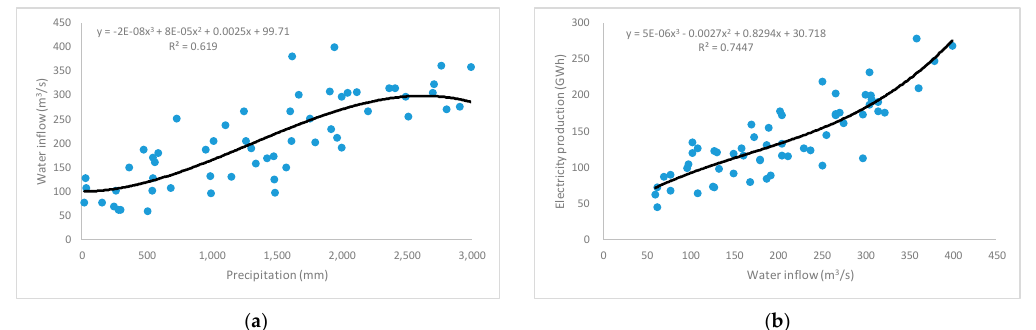
Figure A1. The correlation between precipitation, water inflow, and electricity production: Cirata HEPP. Source: own analysis. ( a ) Monthly water inflow as a function of precipitation 1F (precipitation data from seven weather stations): Cirata HEPP 2013–2017. ( b ) Monthly electricity production as a function of water inflow: 2013–2017.